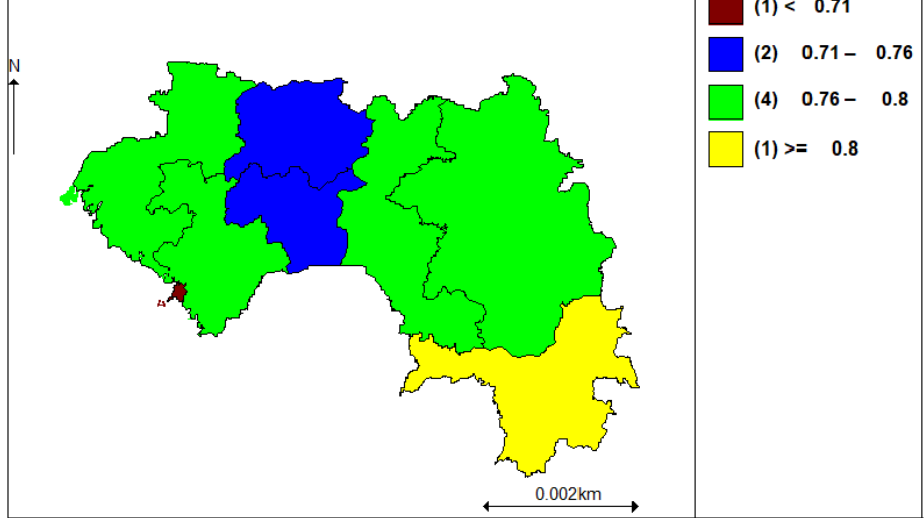
Figure 2. Prevalence categories of